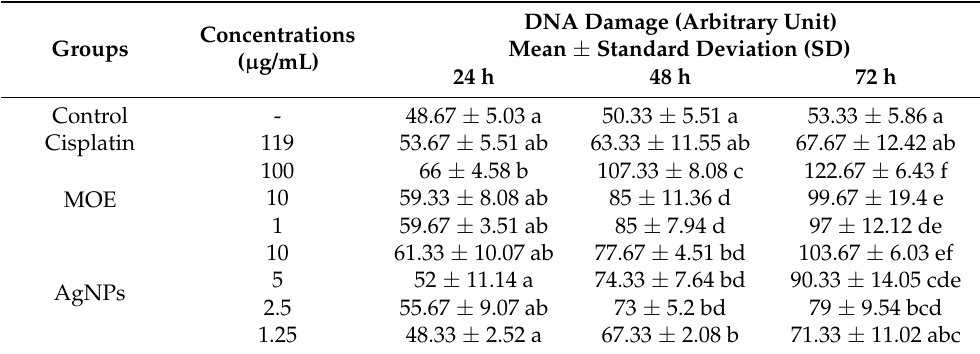
Table 1. DNA damage at different concentrations of M. oleifera extracts (MOE) and biosynthesized AgNPs in MCF-7 cell lines.